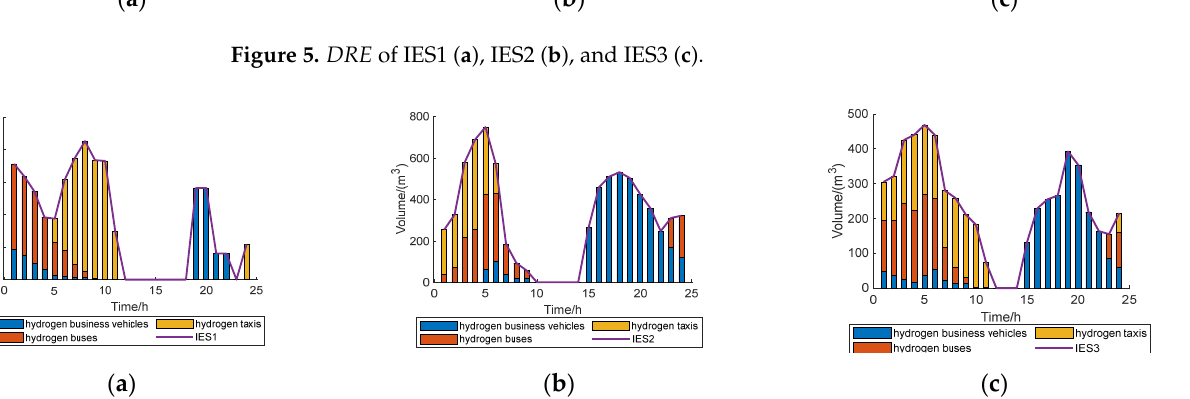
Figure 5. DRE of IES1 ( a ), IES2 ( b ), and IES3 ( c ).